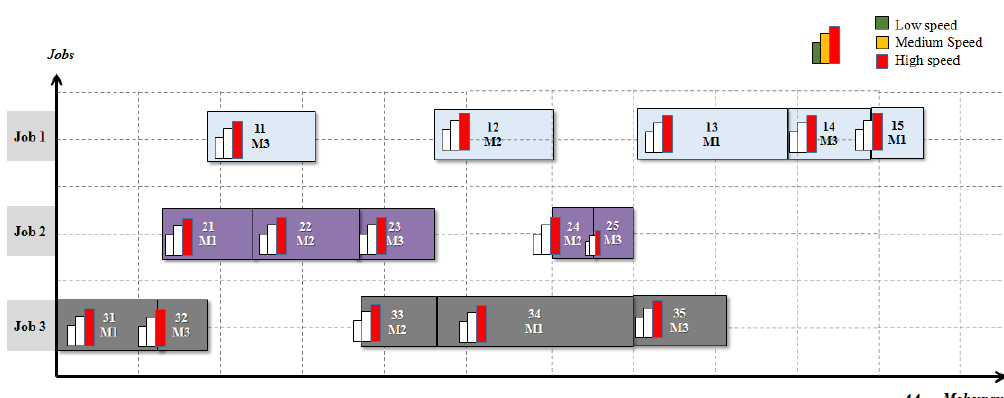
Figure 11. Profiling of the machine speed used in the predictive